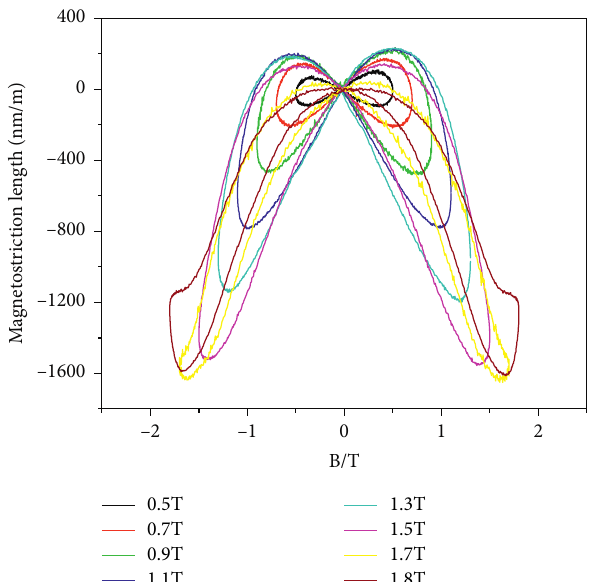
Figure 6: Magnetostrictive butterfly curves under different mag- netic flux densities.